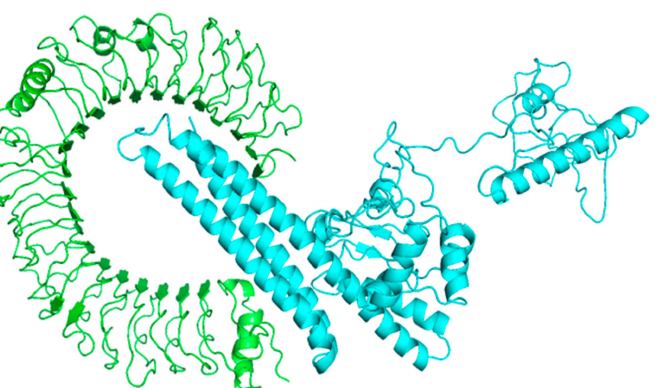
Figure 10. Toll-like receptor 4 (TLR4) complex docked with vaccine constructs. The Cyan color represents the vaccination surface, and the green color represents the TLR-4 receptors.